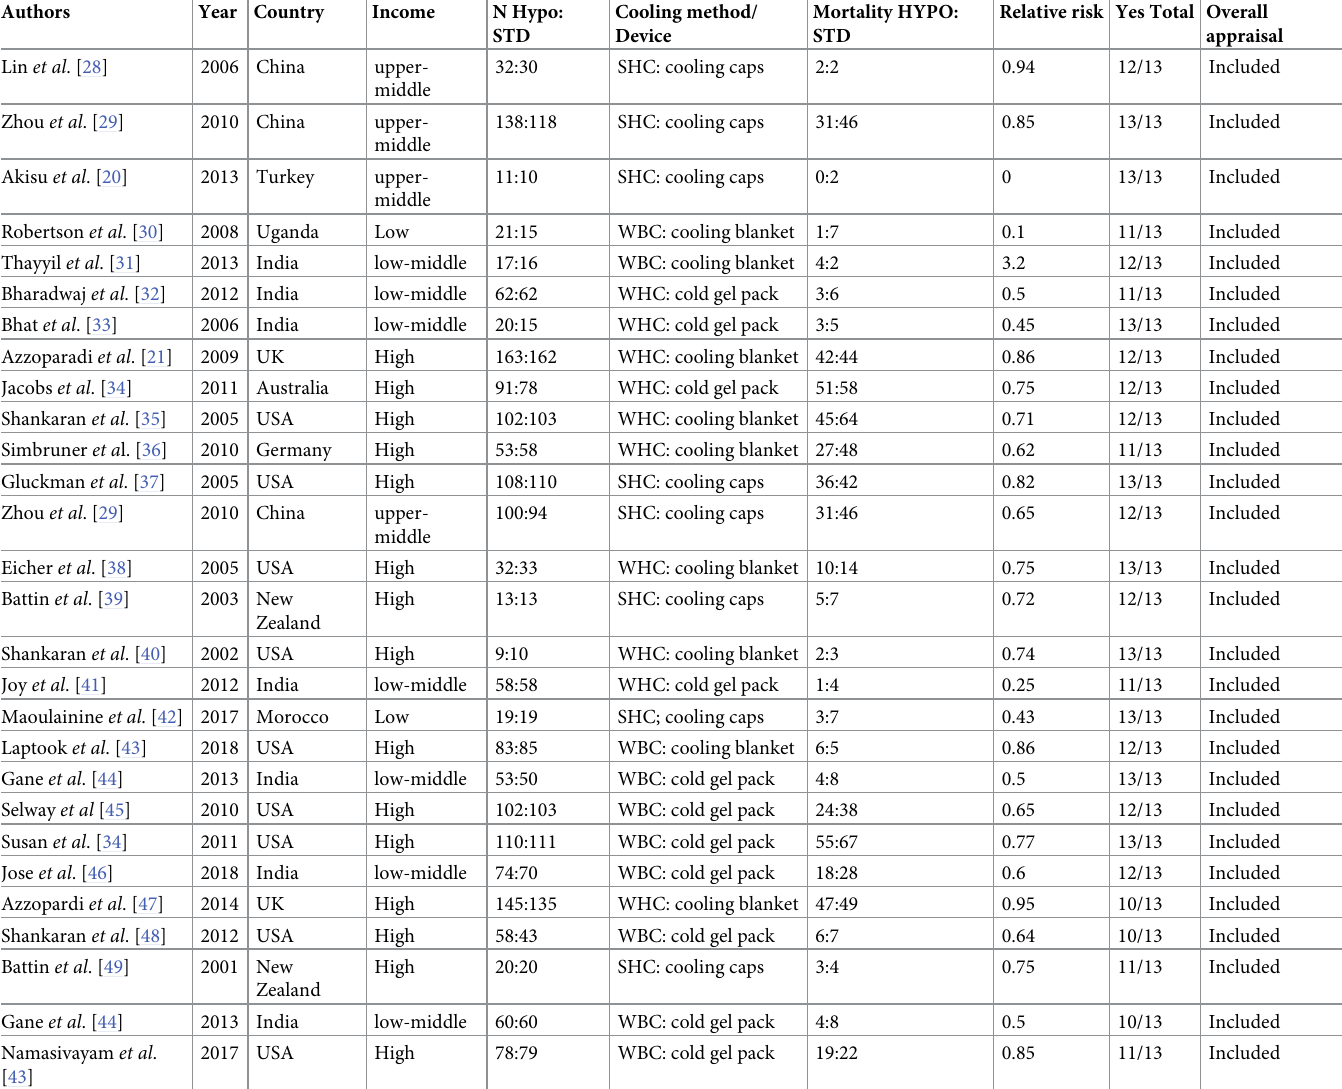
Table 1. Distribution of studies on the effects of therapeutic hypothermia on death among asphyxiated neonates with hypoxic-ischemic